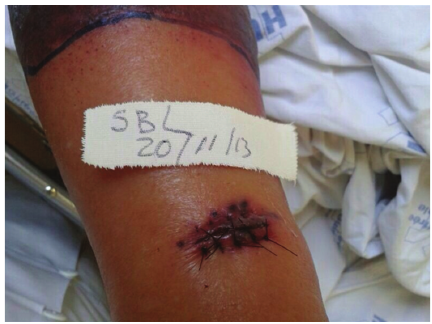
Figure 2: Lesion at the skin biopsy site. Aggravation of the injury at the skin biopsy edges, particularly at the suture sites.